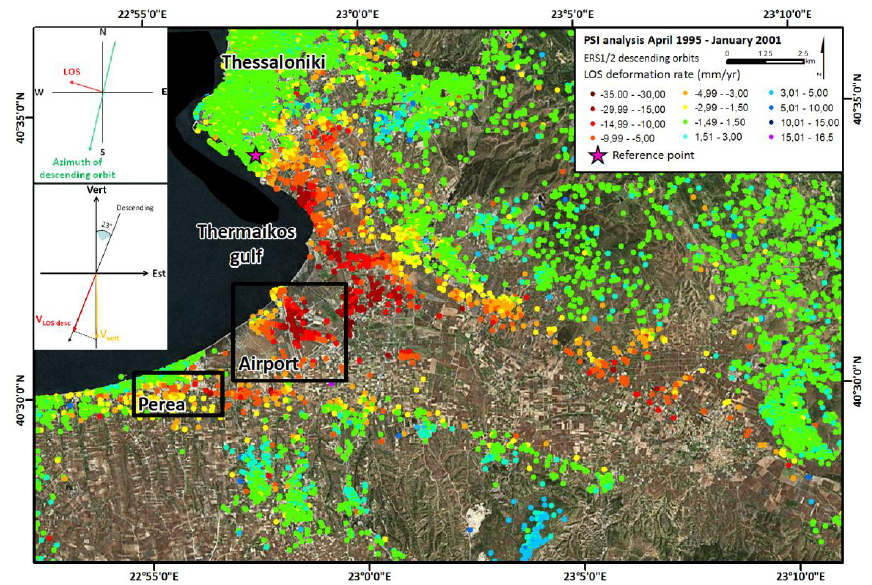
Fig. 6. LOS deformation rates in the Anthemountas basin. PSI map is overlaid on Visual Earth imagery. Adopted classification reflects the classes of the histogram of Fig. 5. In the inset: Line Of Sight (LOS; red vector) for ERS1/2 in descending mode; green vector, azimuth direction; yellow vector, vertical component of deformation.